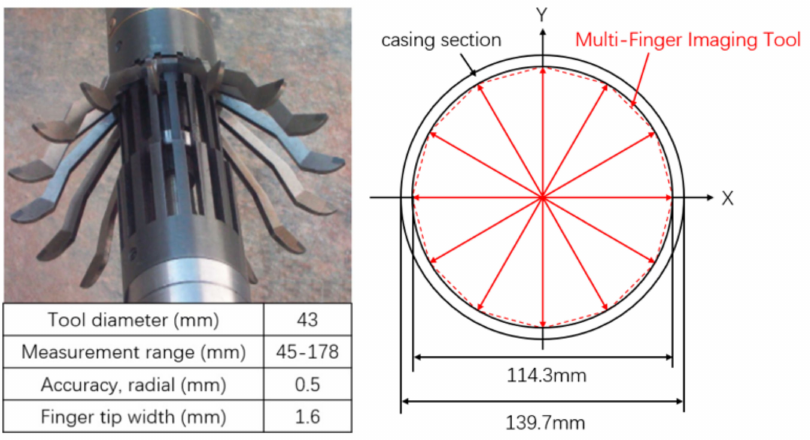
Figure 2. The Multi-Finger Imaging Tool ( left ), and schematic diagram of typical results ( right